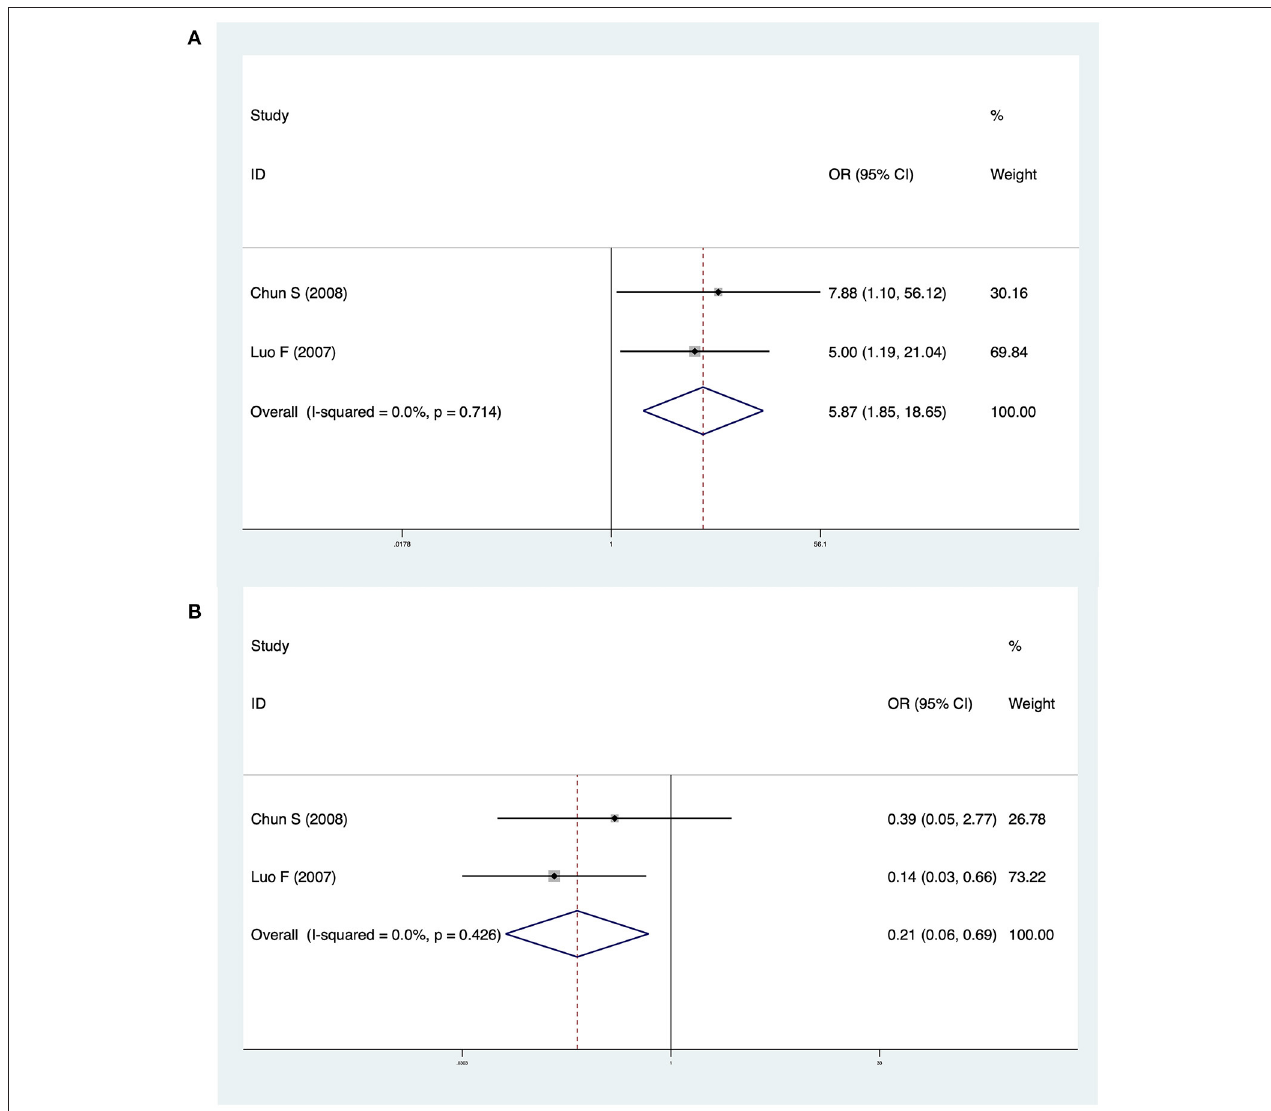
FIGURE 5 | (A) Forest plot of jaundice clearance in CMV-Ig-positive BA vs. CMV-pp65-positive BA. (B) Forest plot of cholangitis in CMV-Ig-positive BA vs. CMV-pp65-positive BA